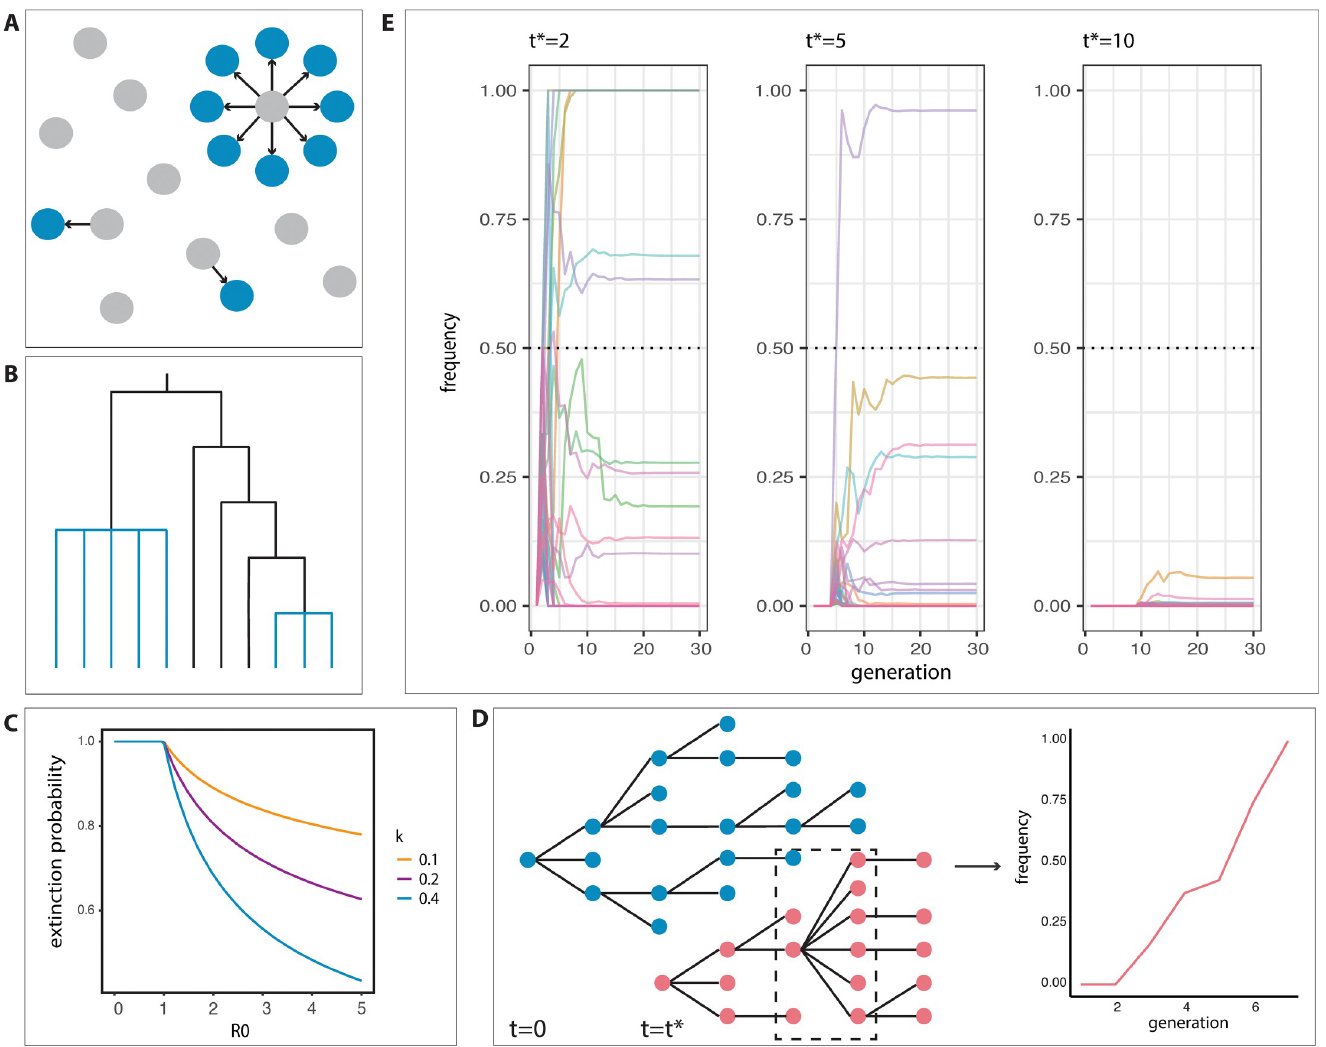
Fig 4. Effects of superspreading events on allele frequency trajectories. (A) Example of overdispersion in secondary case numbers. In this scenario, 10% of infected individuals in a previous generation (grey) give rise to 80% of new cases (blue), as has been reported for SARS-CoV-2 transmission. (B) Example of a simple multiple- merger coalescent, with multiple-merger events highlighted in blue. (C) Extinction probabilities for a negative binomial branching process with parameters R 0 2 [0,5], k 2 {0.1,0.2,0.4}. Probabilities were evaluated numerically as the solution to g ( s ) = s using the expression for the probability generating function g(s) as given in [12]. (D) Schematic of a multitype branching process model, with an initial type (blue) as well as an introduced type beginning at time t � (red). An example of a superspreading event is shown in the black dashed box. The plot on the right shows the resulting frequency trajectory of the introduced type. (E) When both types have a negative binomial offspring number distribution with identical parameters (i.e., the neutral case), the frequency of replacement by the introduced type is dependent on the introduction time t � . Simulations are of a two-type negative binomial branching process with introduction of the second type at t � . Both types have parameters R 0 = 2 and k = 0.4. Simulations were run 100 times for 30 generations each, with only runs in which the initial type is nonextinct at t � visualized.